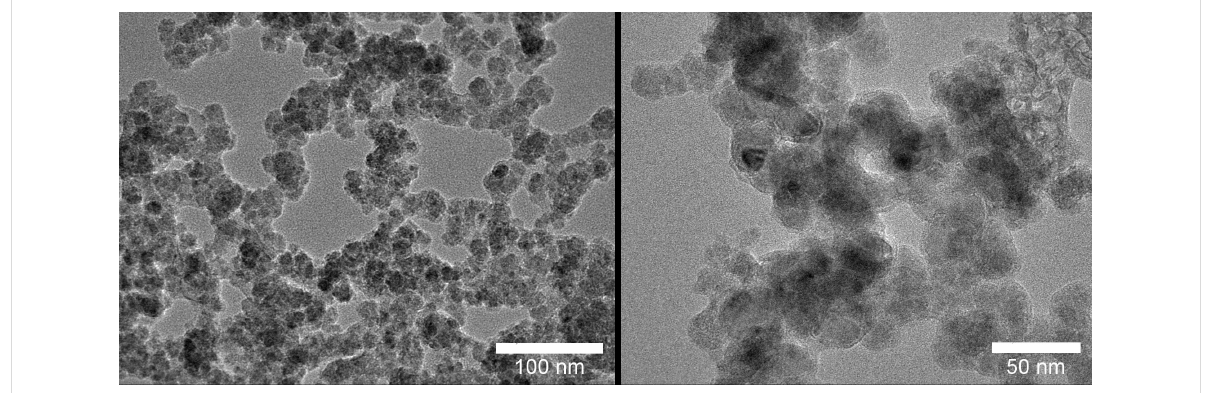
Figure 3: TEM images of the nanosized SiC samples synthesized in the atmospheric pressure microwave plasma reactor; the samples were taken from experiment III in Table 2.